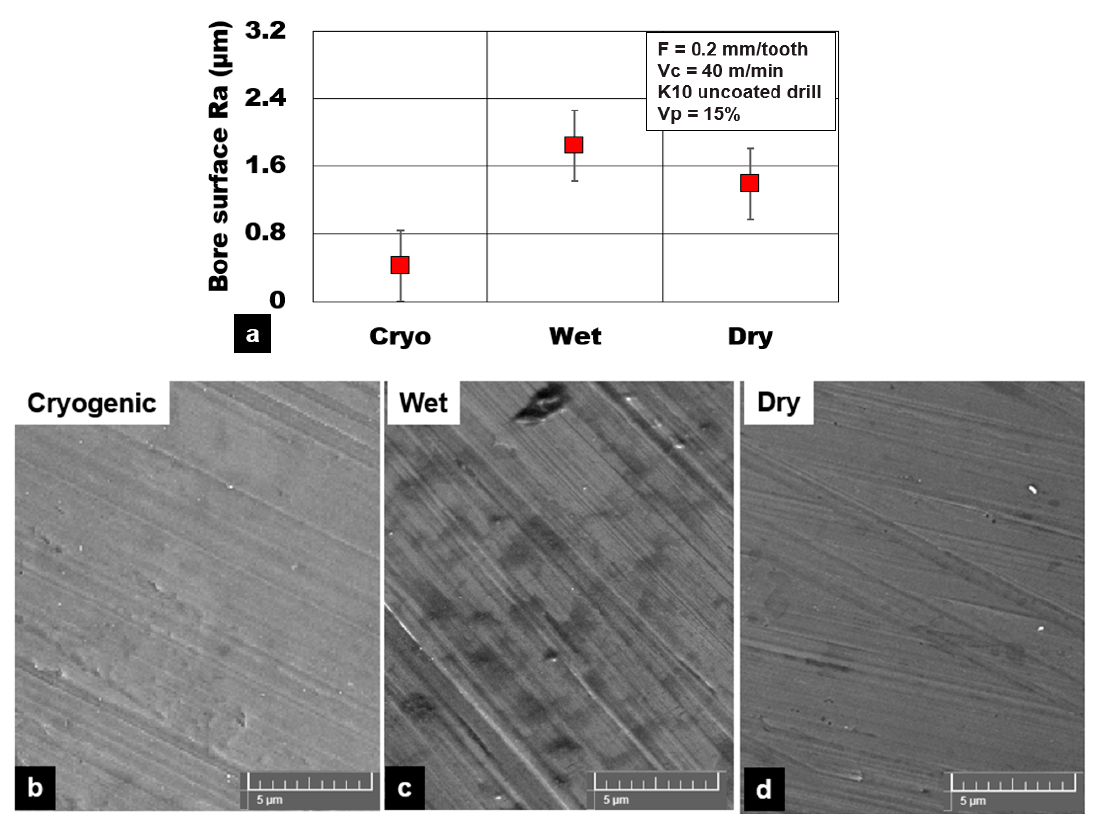
Figure 6. Effect of cooling medium on machined bore surface roughness (Ra) during plunge drilling of AZ31-15% hollow alumina syntactic foam. ( a ) Graphical illustration; ( b ) cryogenic; ( c ) wet; ( d )